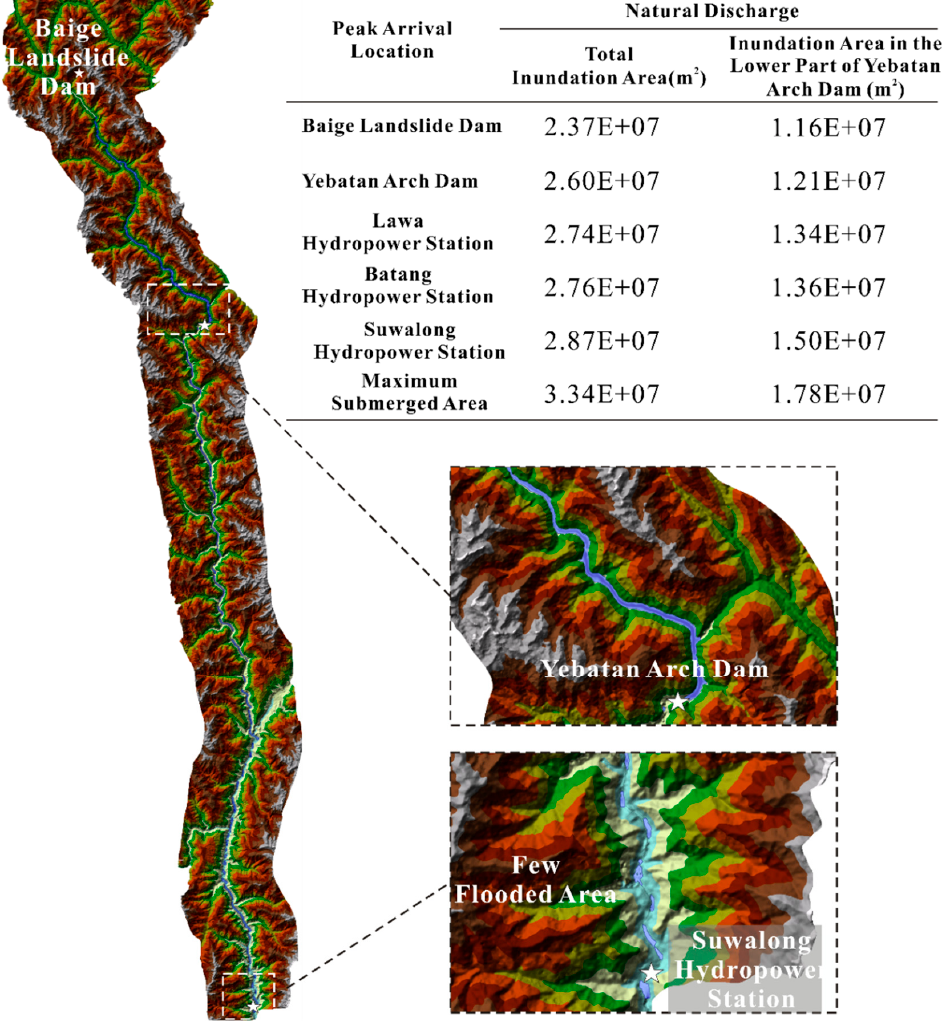
Figure 11. Three-dimensional display of the maximum inundation area in the high dam interception (in the table, the inundation area with the high dam interception).